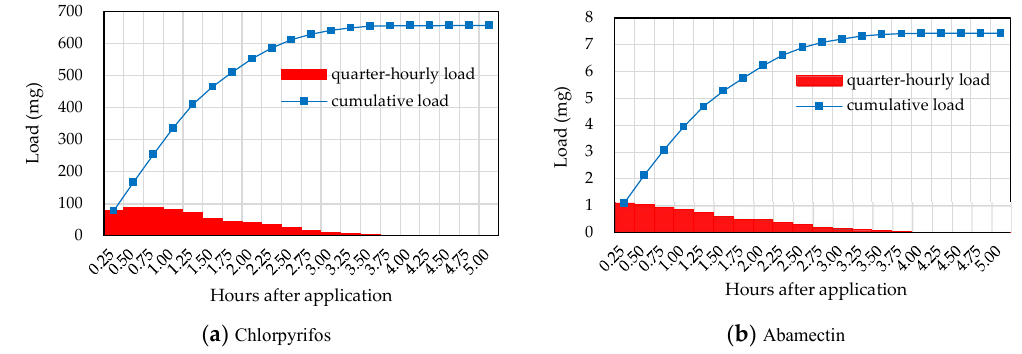
Figure 6. Quarter-hourly and cumulative edge-of-field loads of ( a ) chlorpyrifos and ( b ) abamectin during the 5-h runoff event after spray application.